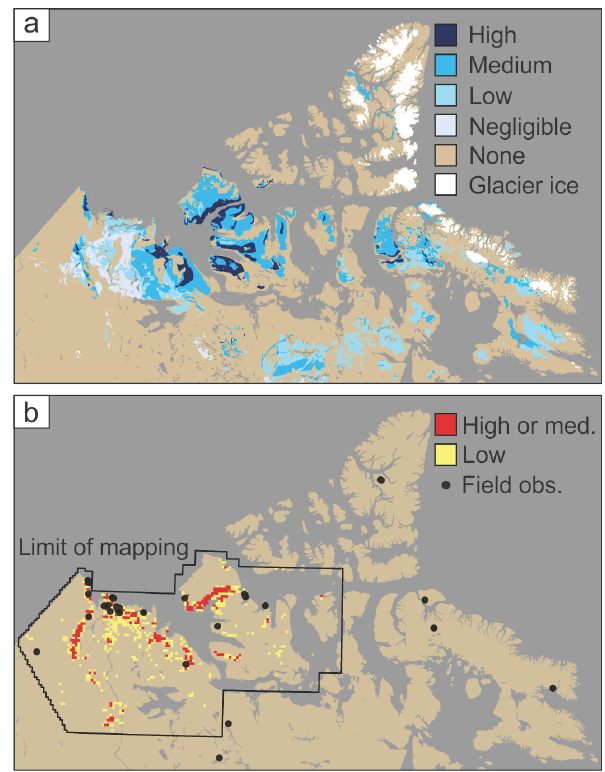
Figure 5. (a) Modelled abundance of relict ice and (b) abun- dance of large ( > 1ha) thaw slumps in northwest Canada (Kokelj et al., 2017; Segal et al., 2016), and field observations of relict ice from the literature (Table S3).